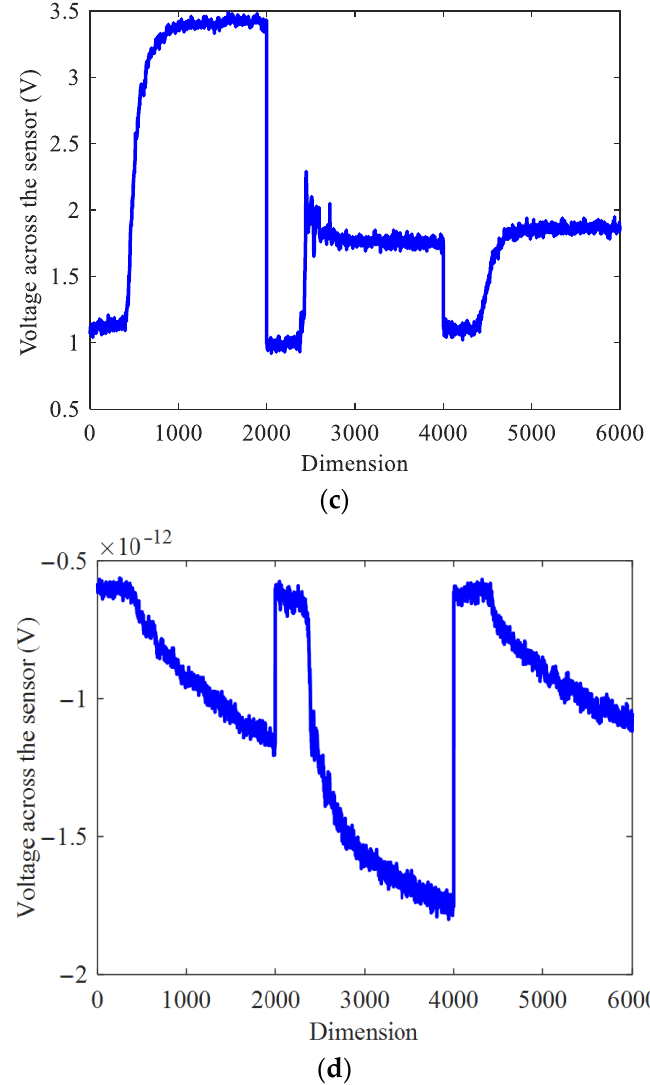
Figure 10. The testing sample and reconstructed samples. ( a ) Testing sample. ( b ) The 1th class reconstructed sample. ( c ) The 2th class reconstructed sample. ( d ) The 3th class reconstructed sample.